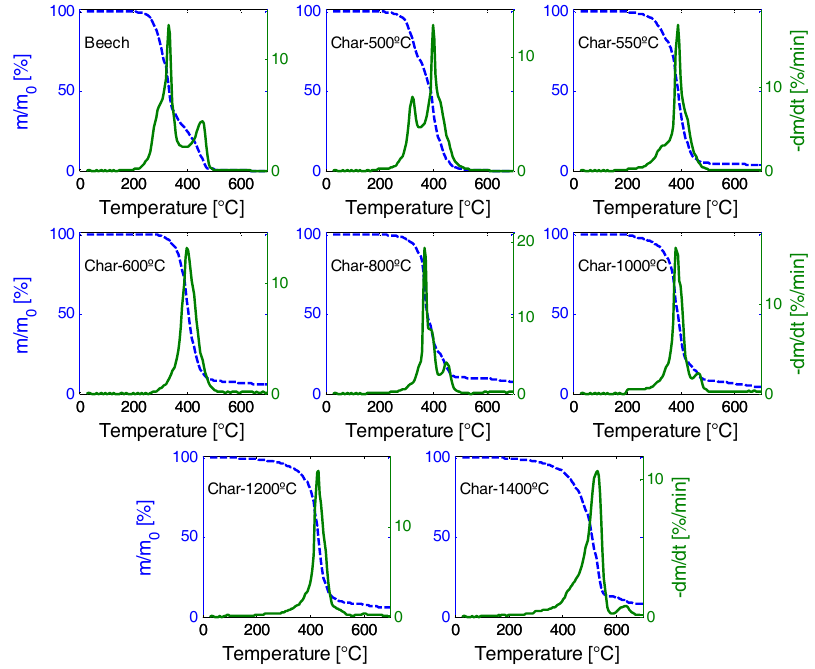
Figure 9. Normalized mass as a function of the temperature in the TG air oxidation experiments of the pyrolysis chars.